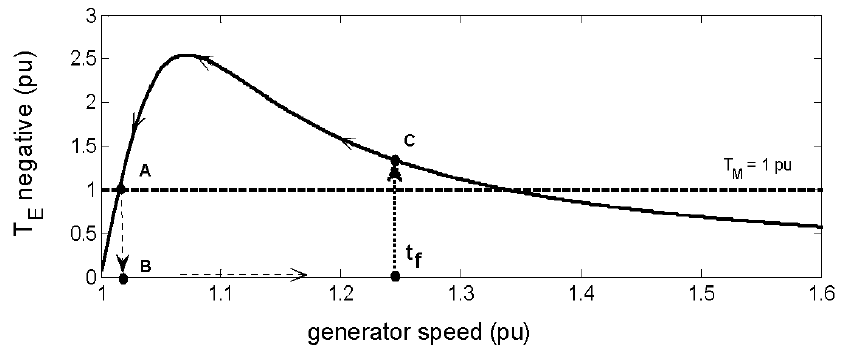
Figure 5. Stable operation of squirrel-cage induction